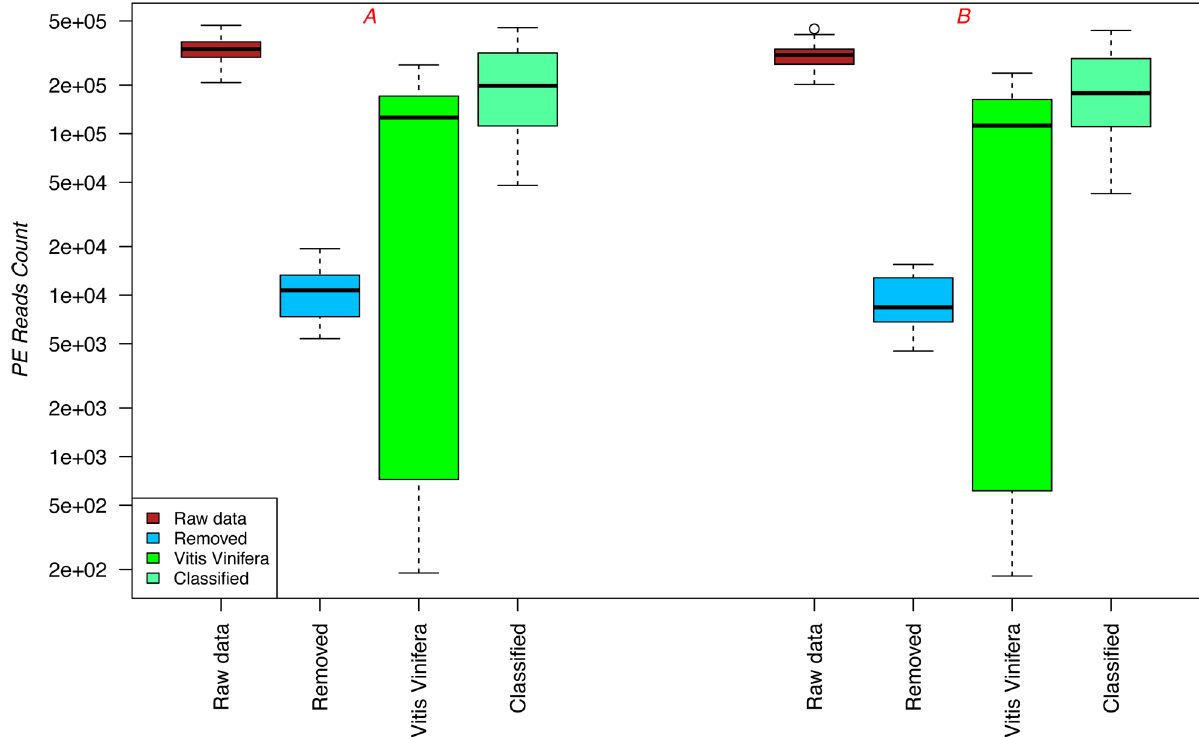
Fig 1. Graphical summary of the results obtained by applying the BioMaS pipeline. Box plot showing the number of PE reads that were produced by the MiSeq platform for both sequencing runs (raw data), including low quality reads removed after denoising, host reads mapped to Vitis vinifera , and bacterial reads taxonomically classified by